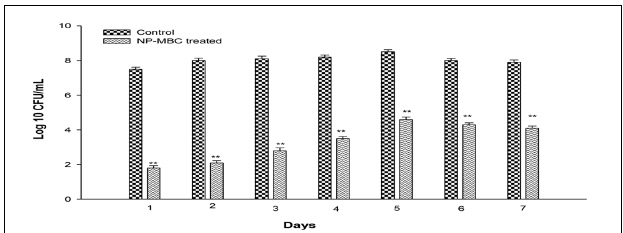
FIGURE 3 | Bacterial count [Log 10 (CFU/ml)] in K. pneumoniae biofilm grown for different days and treated with H-AgNPs. The experiment was performed in duplicate and repeated at least three times on different days. Bars represents standard deviation and ∗∗ denotes P -value ( P < 0.01).